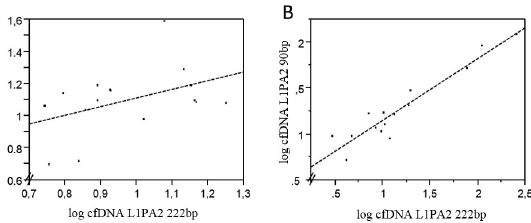
Fig 3. Increasesin cfDNAat rest, due to previous training sessionsmostly involve increasesin poly- nucleosomal DNA. Linearcorrelations of total nucleosomal cfDNA (cfDNA (cid:21) 90bp)with polynucleosomal cfDNA (cfDNA (cid:21) 222bp)followinga singletrainingsessionat study day one (A) and at study day two (B). While a highlysignificant correlation was foundat study day two (r = 0.95; p < 0.0001),no significantcorrelationswere foundat study day one (as shownin